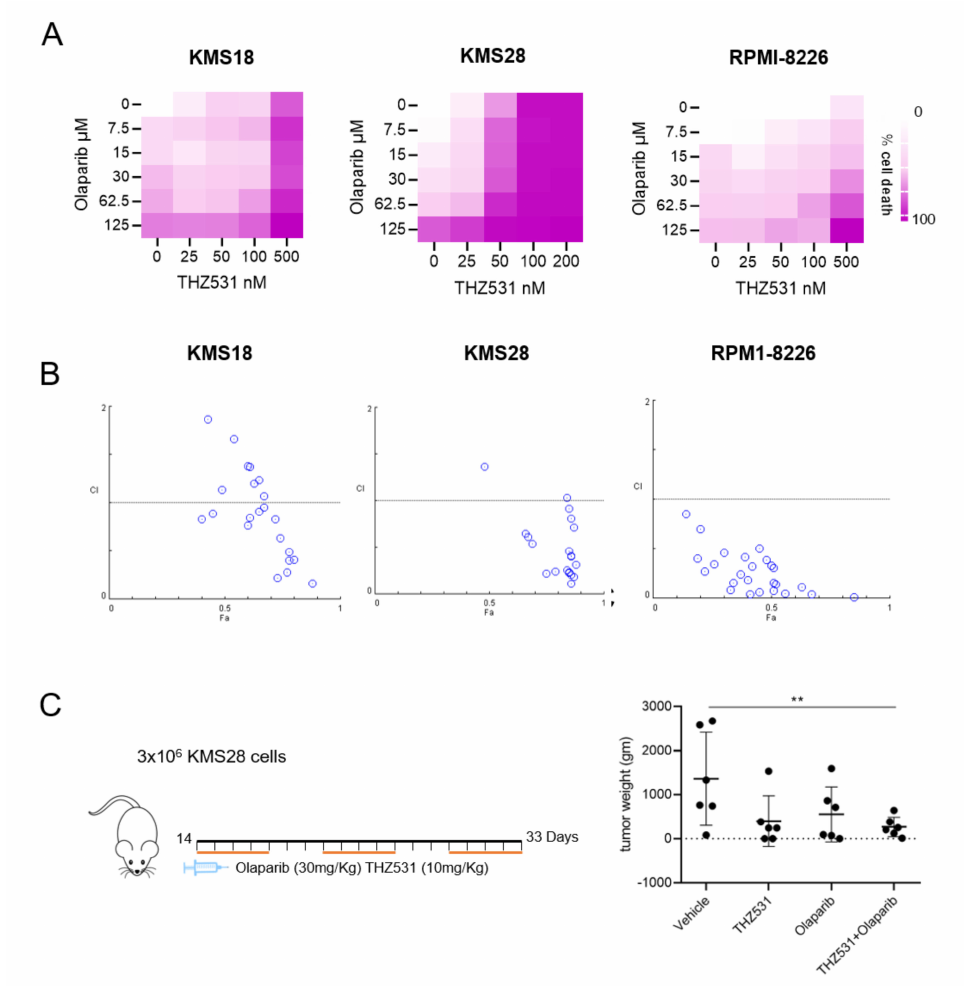
Figure 4. THZ531 and Olaparib are synergistic in multiple myeloma cells. ( A ) MTT assay of KMS18, KMS28, and RPMI-8226 multiple myeloma cells in the presence of THZ531 and PARP inhibitor Olaparib. ( B ) Combination index (CI) prediction of Olaprib and THZ531 treatment. CI defines interaction between the two compounds. CI < 1, CI = 1, and CI > 1 represent synergism, additive, and antagonism. ( B ) NSG mice were injected subcutaneously with 3 × 10 6 KMS 28 cells, and mice were randomized into 4 groups ( n =6 mice per group). When tumors became palpable, groups were treated with vehicle (DMSO), THZ531 (10 mg/kg i.p. five times a week), Olaparib (30 mg/kg oral gavage, five times a week), or the combined treatments of THZ531 and Olaparib. ( C ) Volume measurement of harvested tumors, 3 weeks post treatment. ** p <